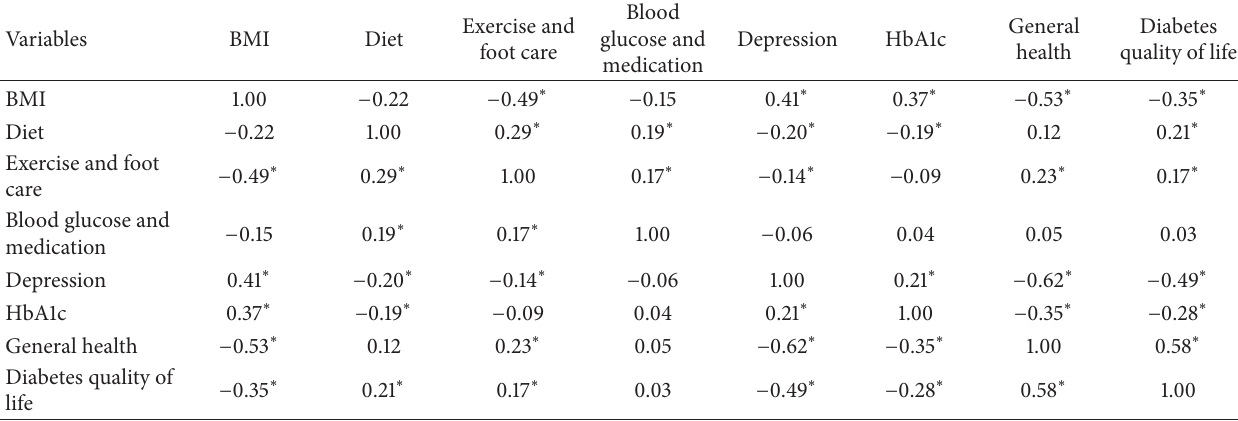
Table 2: Pearson’s correlation coefficients of variables used in the SEM.